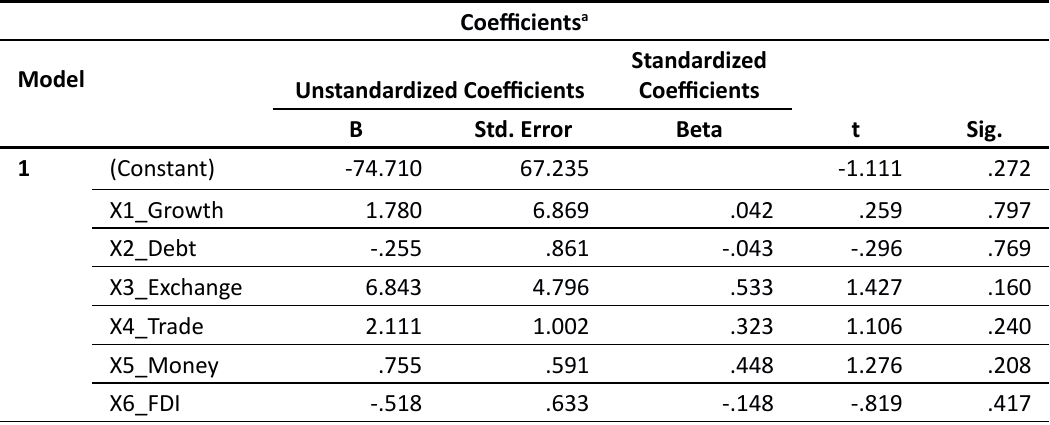
Table 4: Heteroskedasticity Test